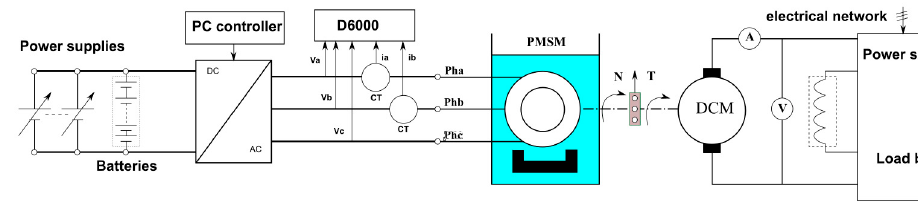
Figure 23. Experimental design.